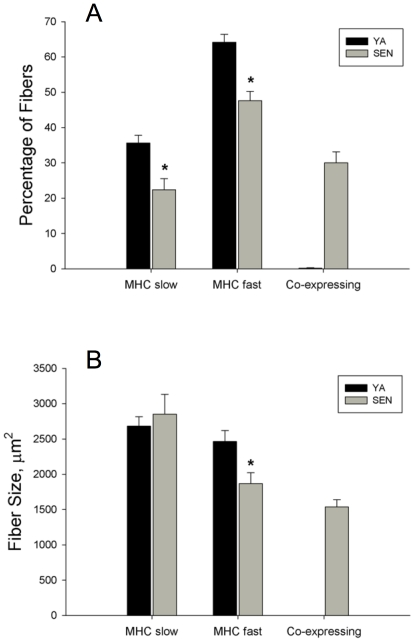
Fiber type proportion and fiber size in young adult (YA) and senescent (SEN) muscle.Panel A depicts the percentage of fibers in each MHC class examined (*P<0.05 vs YA; too few MHC co-expressing fibers in YA to permit statistical comparison to SEN). Panel B depicts differences in fiber size according to each MHC class examined (*P<0.05 vs YA).